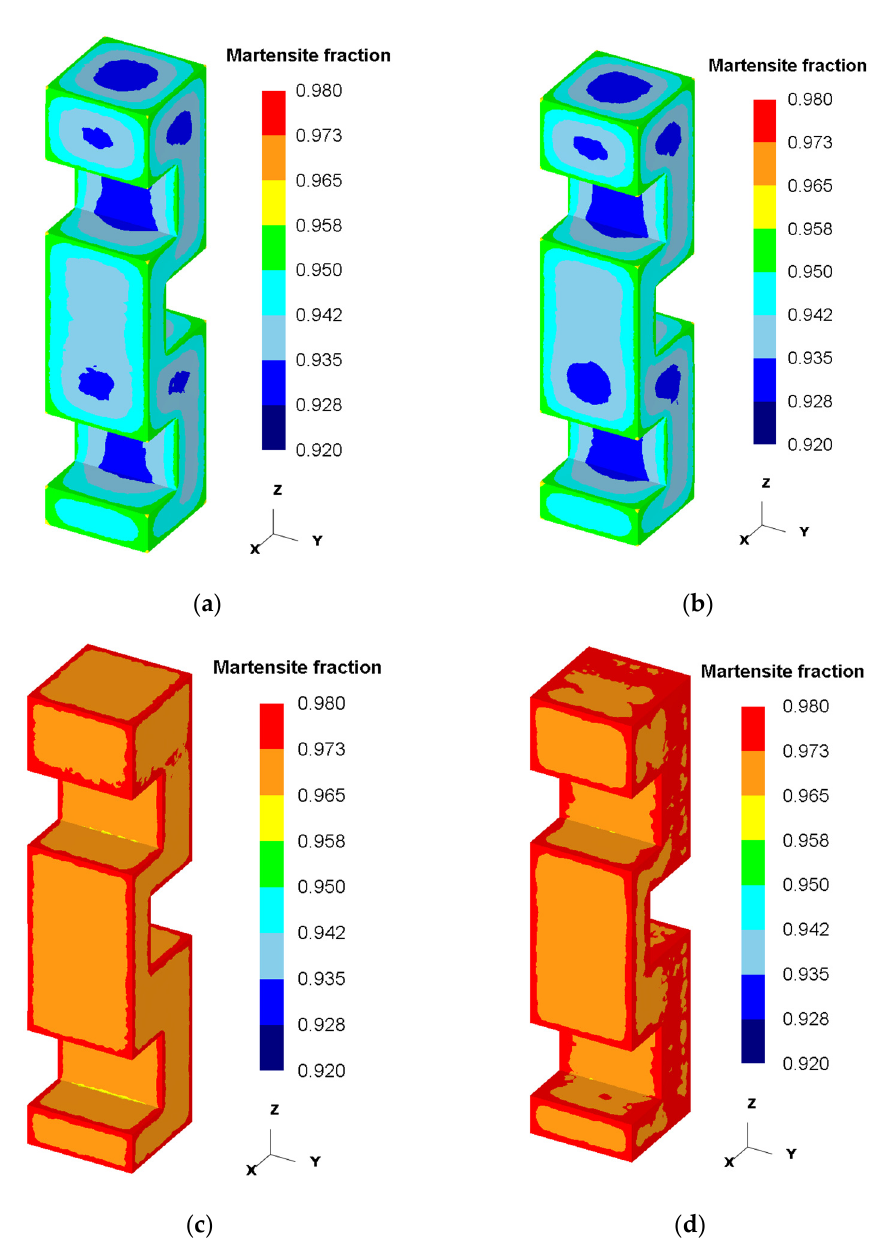
Figure 10. Martensite distribution in samples: ( a ) vertical oil quench; ( b ) horizontal oil quench; ( c ) vertical water quench; and ( d ) horizontal water quench.